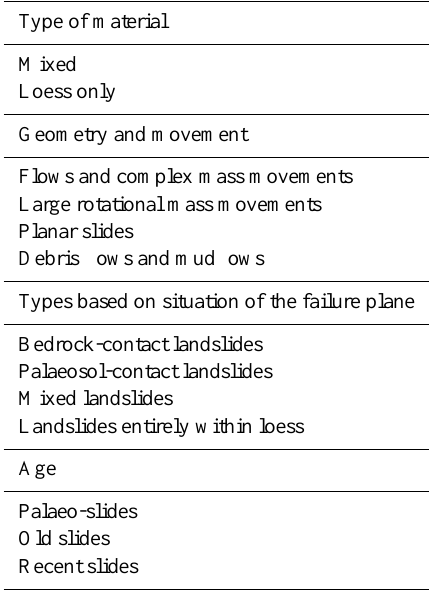
Table 1. Classification of landslide types in the study area.